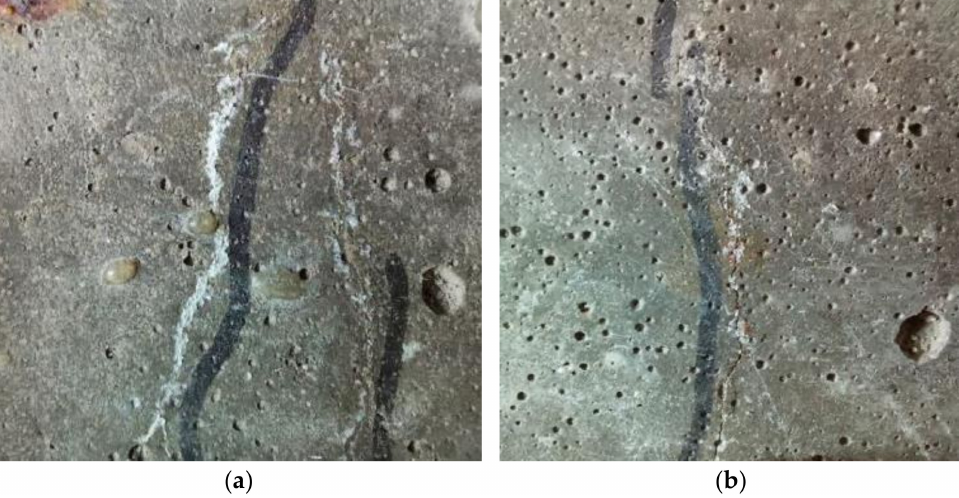
Figure 8. Completely self-healed crack ( a ) and partially self-healed crack ( b